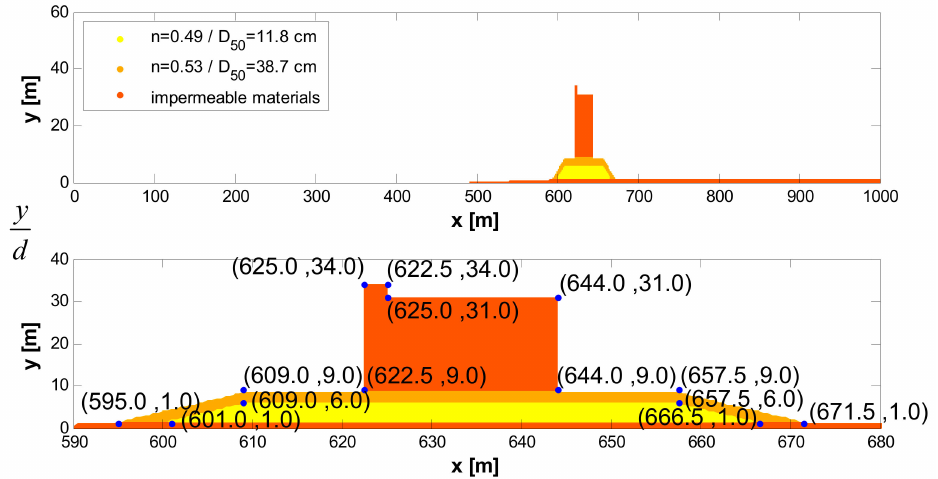
Figure 5. The wave-structure interaction model setup of Taichung harbor setup